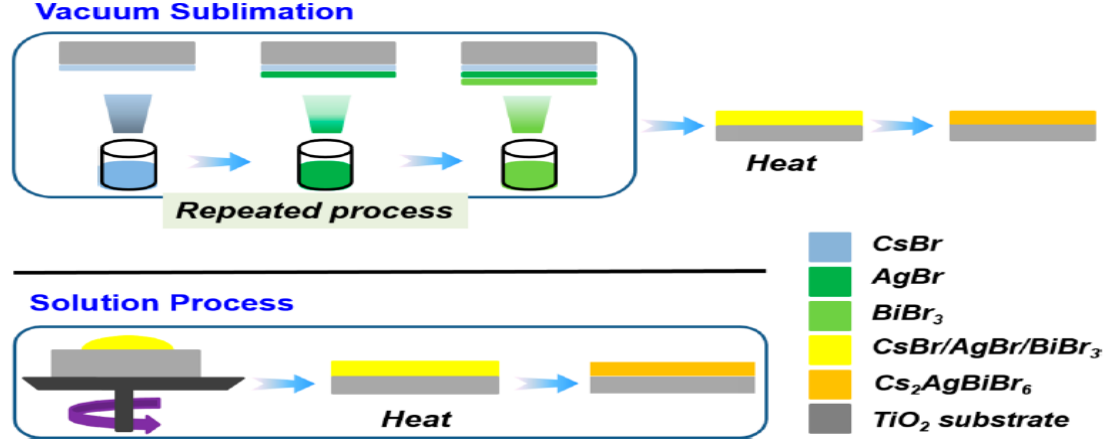
Figure 14. Preparation sketch of Cs 2 AgBiBr 6 thin film through vacuum-sublimation and solution-processing. Reproduced with permission from [83] . Copyright 2019, American Chemical Society.